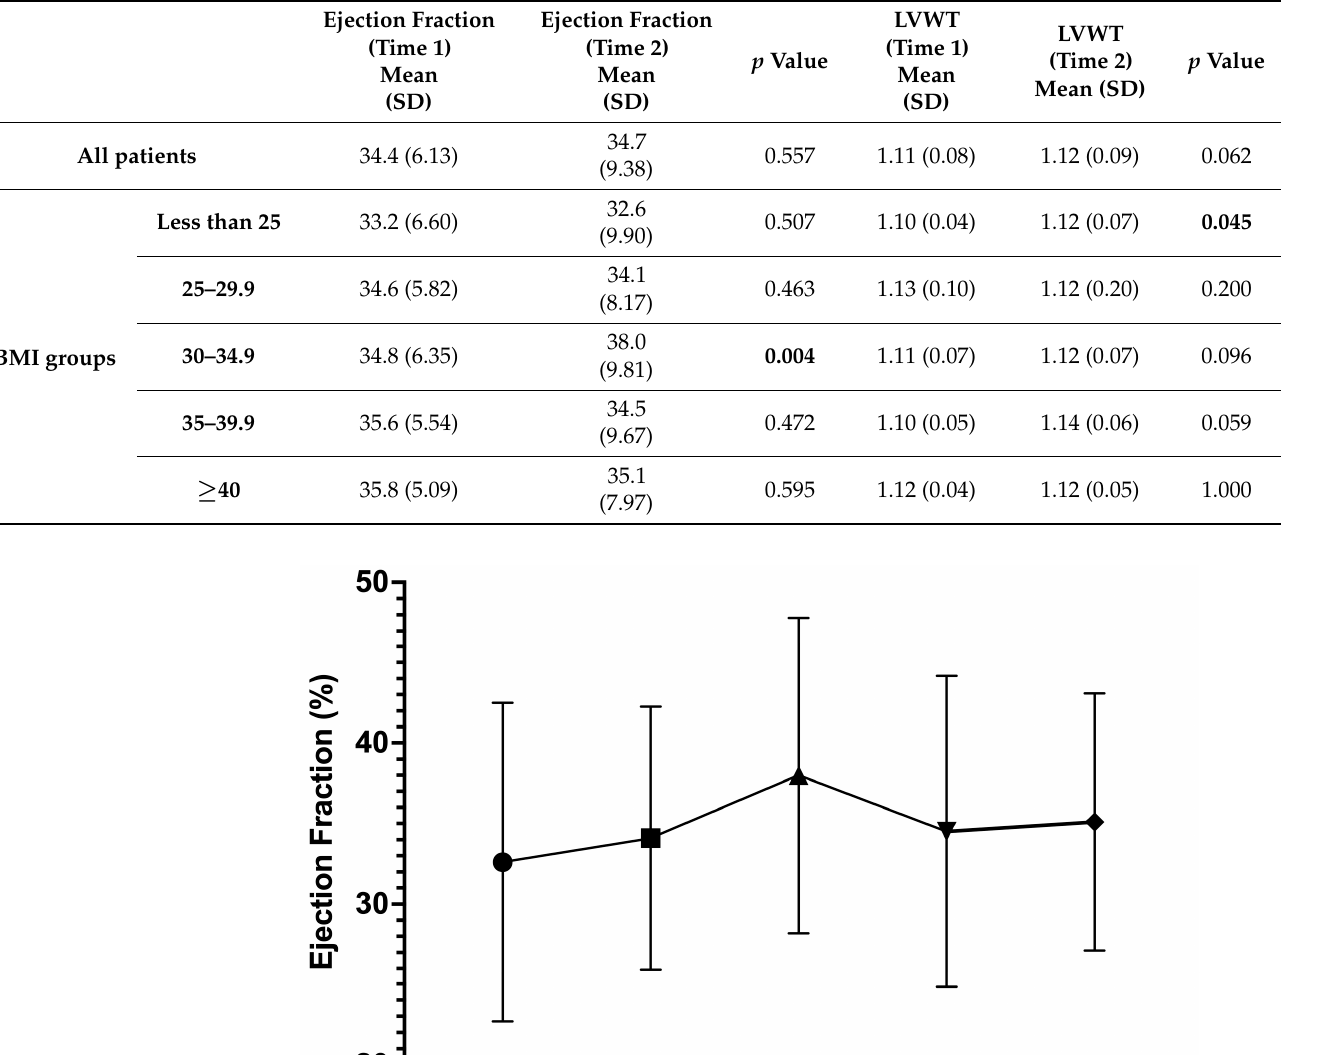
Table 2. Effect of obesity on ejection fraction (EF) and left ventricular wall thickness (LVWT) after 1 year.